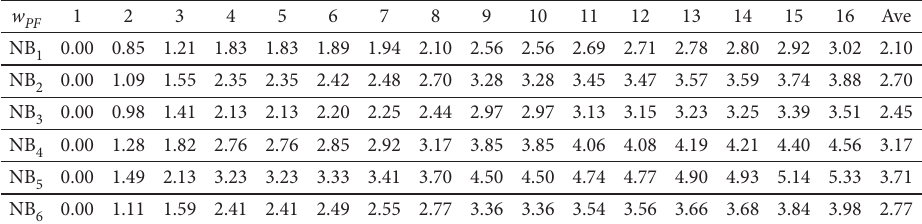
with FS-OWAD operator PF